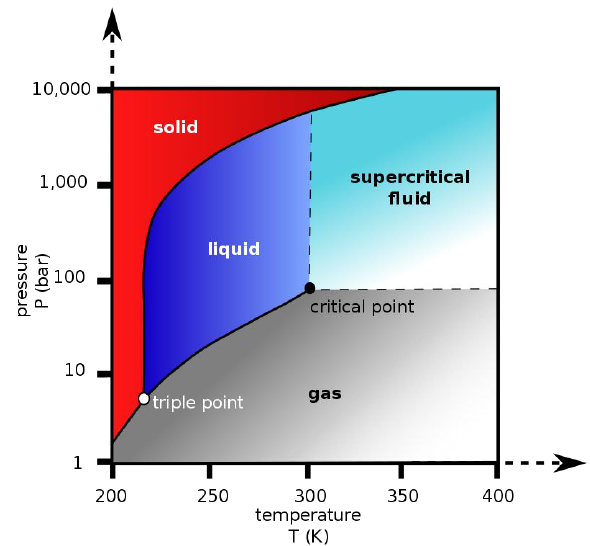
Figure 1. Carbon dioxide phase diagram showing the critical point. Reproduced under the terms and conditions of the liberal Creative Commons Attribution 4.0 International (CC BY) license from [5]. Copyright © 2019 The Authors.